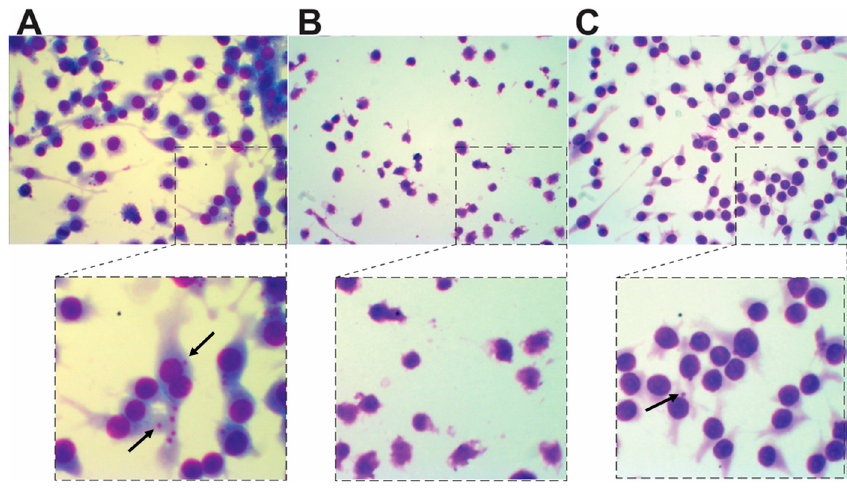
Figure 5. Representative micrographs showing RAW macrophages infected with L. (L) infantum chagasi that were or were not treated compounds 7 or 8 . The infected macrophages were treated for 24 h with 1% DMSO (control) ( A ); 75 µM of compound 7 ( B ); or 75 µM of compound 8 ( C ). The pictures are representative of all of the experiments, which were conducted as independent triplicates. The upper pictures are magnified at 100x, and the lower panels are zoomed in images of the selected parts of the upper pictures. The black arrows indicate intracellular amastigotes.